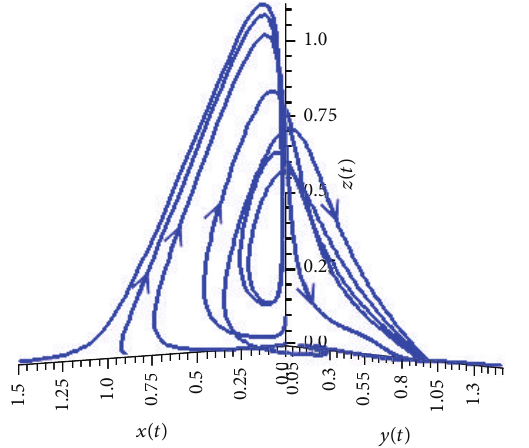
Figure 8: Phase portrait of system (1) for 𝑎 = 1.2 showing the asymptotic stability of the point 𝐵 = (0,1, 0) . Integra- tion time: [0, 500] . Initial conditions: (0.01, 0.01, 0.01) , (0.01, 0.9, 0.01) , (1.5, 0.01, 0.01) , (0.01, 0.2, 0.01) , (0.01, 1.5, 0.01), (0.9, 0.01, 0.01), (0.01, 0.1, 0.01), (0.01, 0.01, 0.1) .